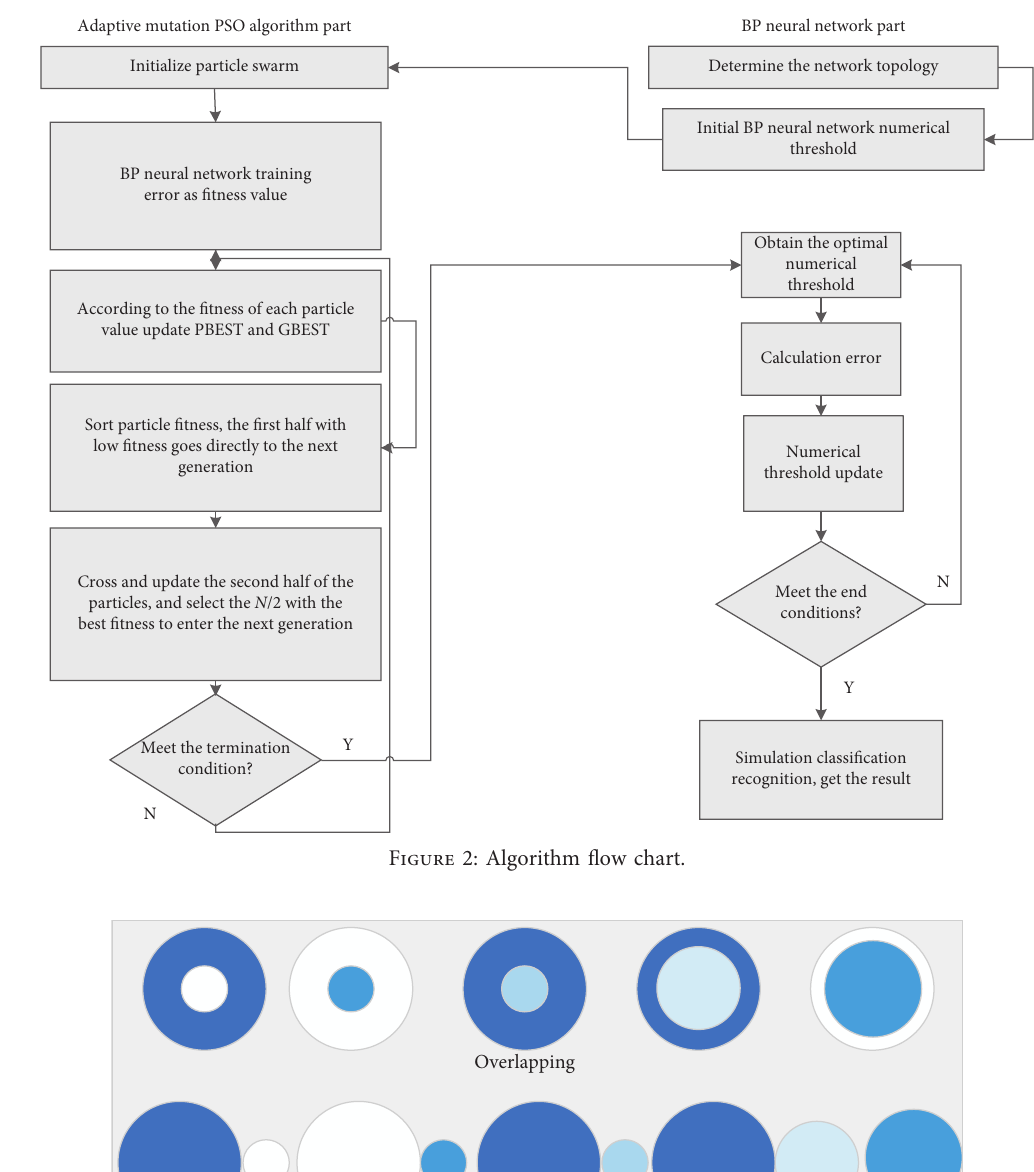
Figure 3: Overlapping and contrasting